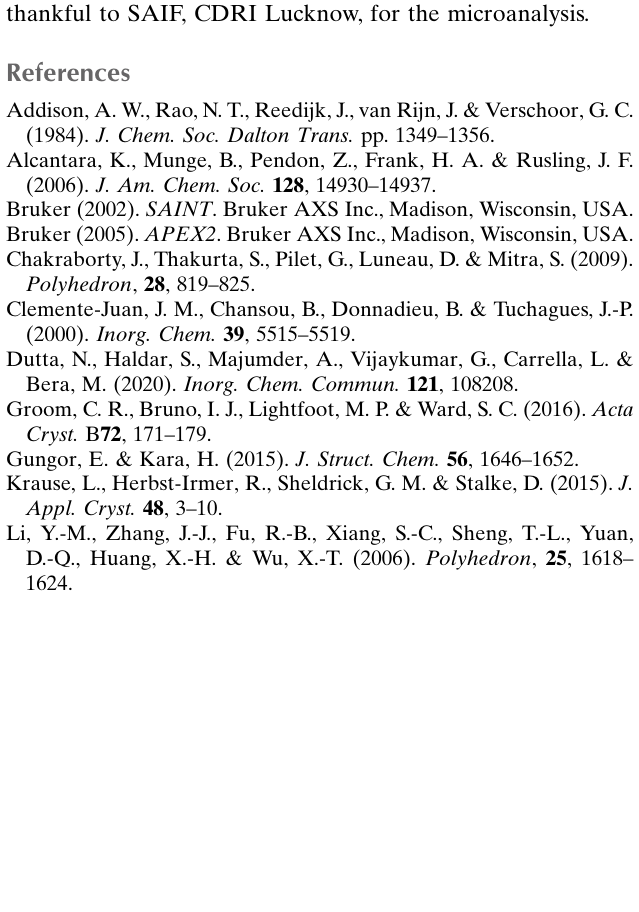
Table 3. H atoms were located in difference-Fourier maps and constrained to ride on their parent atoms with with C—H bond distances of 0.95 A˚ (aromatic H), 0.98 A˚ (methyl H) and 0.88 A˚ (N—H) and were refined as riding with isotropic displacement parameters 1.2 and 1.5 times those of the parent C/N atoms. Water H atoms were refined isotropically with U ı˜so(H) = 1.5 U eq(O). Three of the four perchlorate anions are disordered over two orientations and were restrained to have tetrahedral geometries with occupancies of 0.57 (6)/ 0.43 (6), 0.412 (13)/0.488 (13), and 0.806 (12)/0.194 (12),